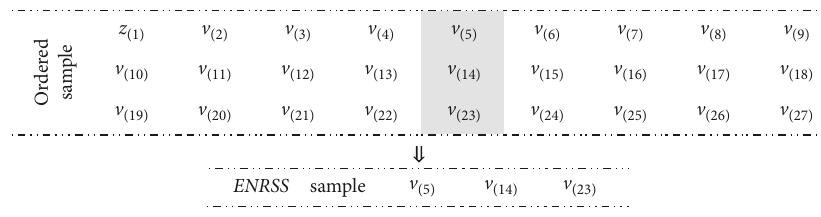
Figure 5: Display of m 3 observations in one cycle and the selected ENRSS sample of size m �